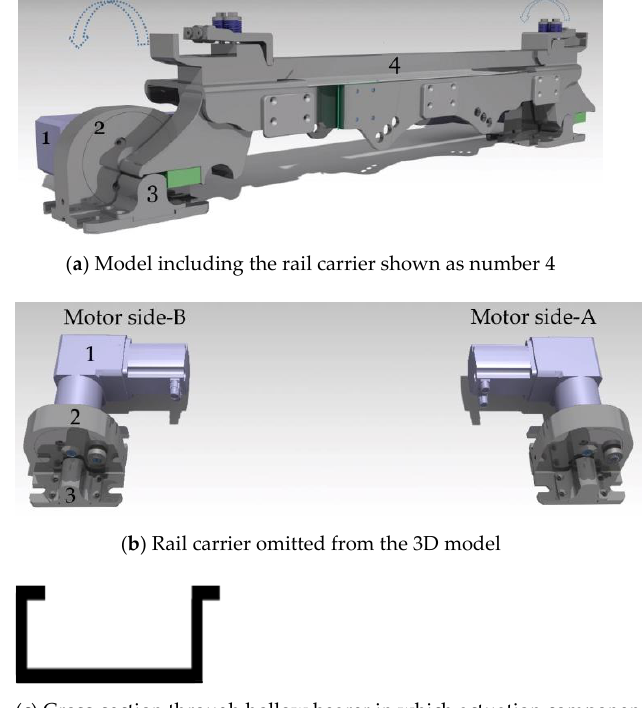
Figure 3. 3D model of a single actuator bearer: 1. Electrical motor and gearbox, 2. Cam and angle encoder, 3. Locking block, 4. Rail carrier for supporting the switch rail ( a – c ).